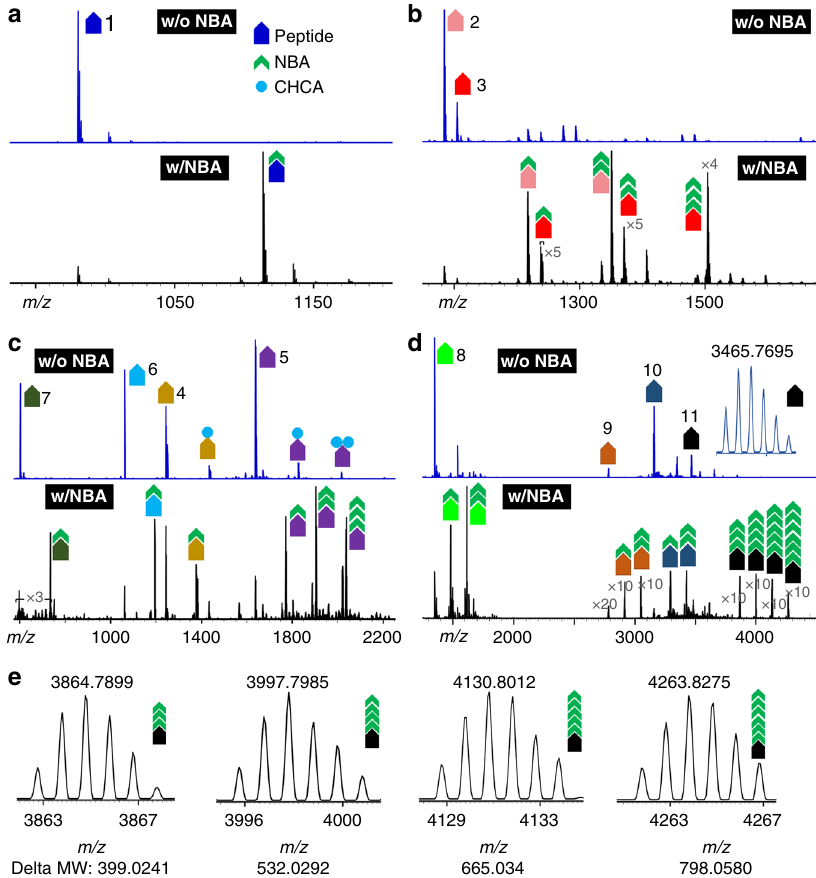
Fig. 3 Highly ef fi cient peptide labeling via nsPCR. A wide range of peptides ( a – d , with increasing masses) with various K-residue numbers were tested using nsPCR labeling. Isotopic distributions of peptide 11 in e and insert in d con fi rmed the accuracy of the labeling results. w/o, without, w/, with. Individual peptide sequence information are listed in Table 1. Source data is provided in a Source Data fi